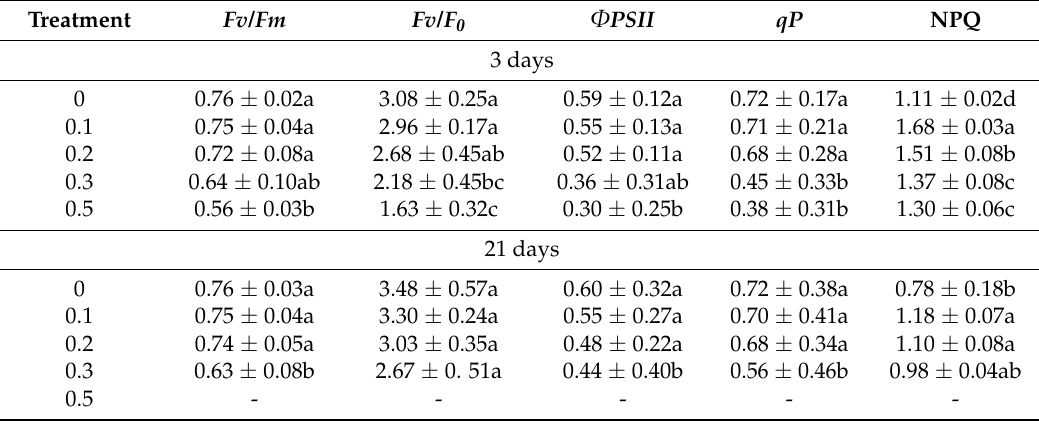
Table 3. Effect of increasing levels of soil salinity on chlorophyll fluorescence parameters